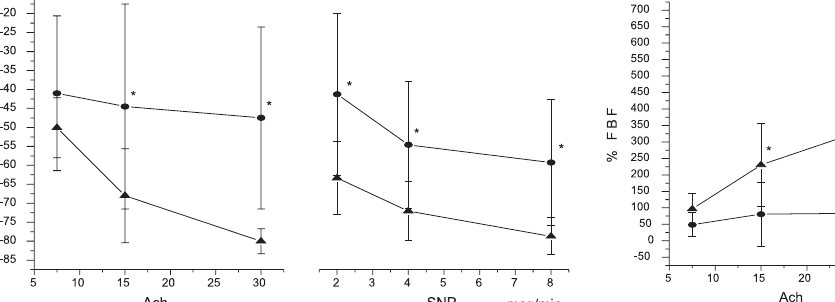
Figure 1 - Vascular resistance decrement (%) after Ach and SNP infusion in subjects with MS (·) and controls (²%). (* P <0.05 intergroup)